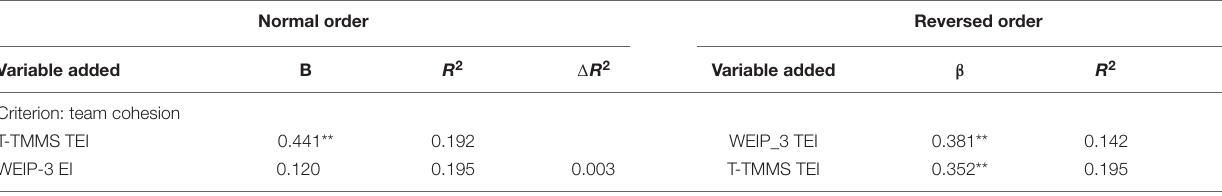
TABLE 4 | Regression results for testing the incremental validity of T-TMMS and WEIP-3 measures. Normal